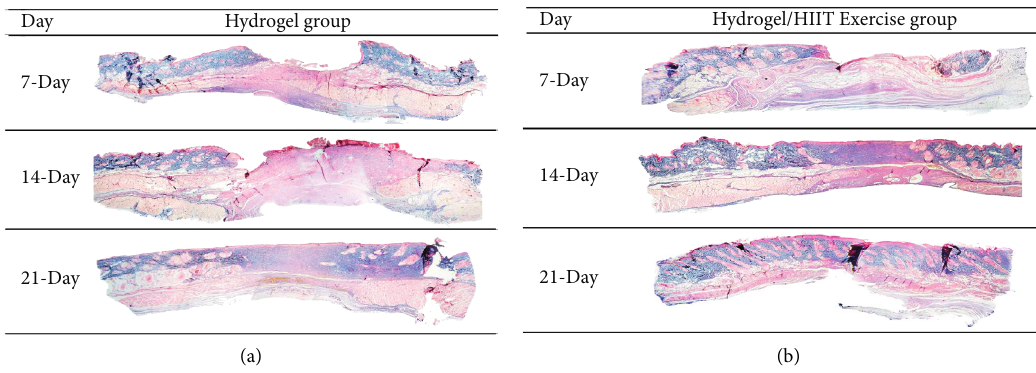
Figure 7: Histological analysis of hydrogel (a: × 40) and hydrogel/HIIT exercise (b: × 40) with Masson’s trichrome staining.